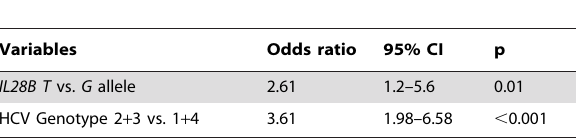
Table 5. Independent predictors of SVR in patients who completed the scheduled 48-week treatment regimen with pegIFN a and